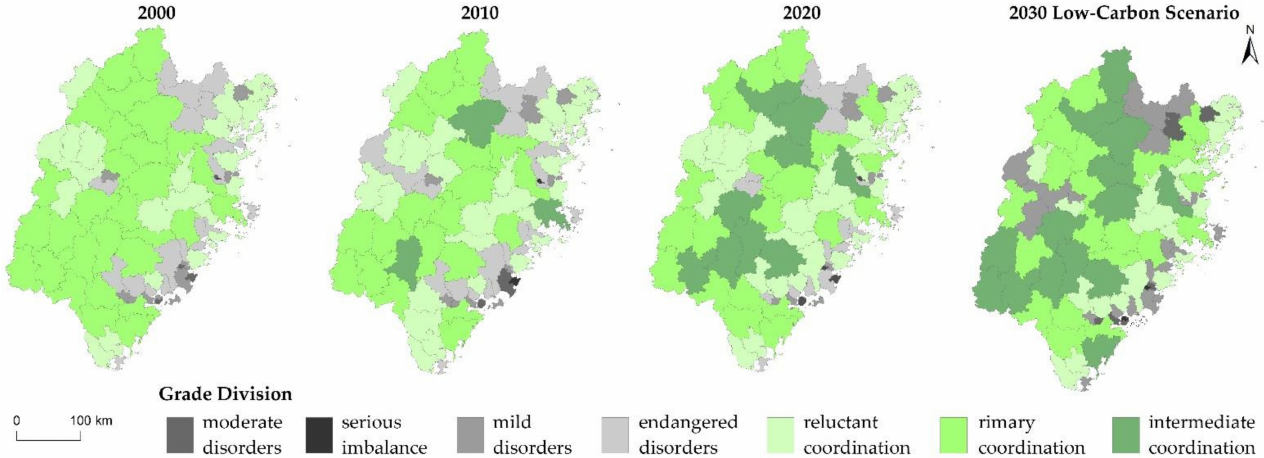
Figure 9. Spatial pattern evolution of coupling coordination relationship among land economy, ecology, and carbon emissions in Fujian